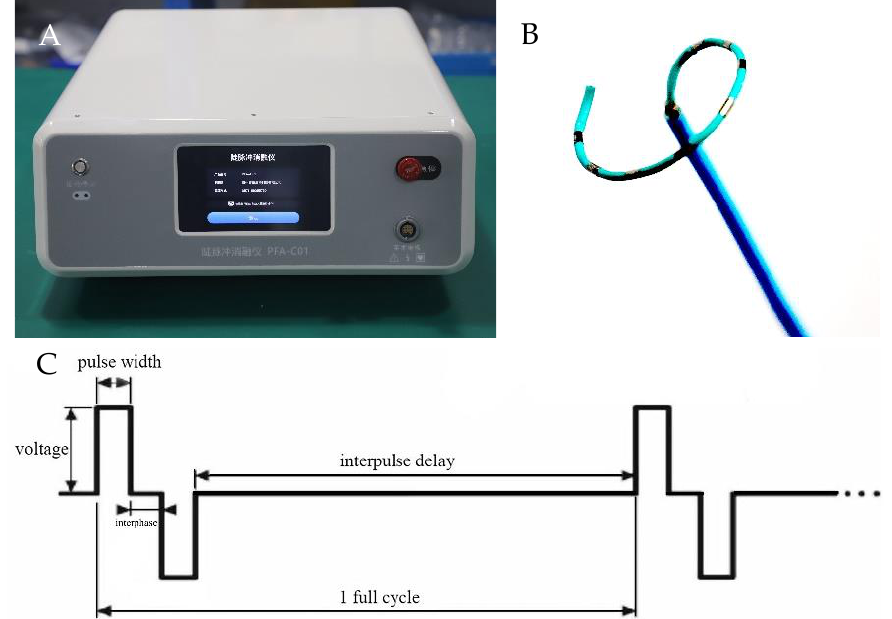
Figure 1. PFA system. ( A ) The biphasic pulse generator was made by Hangzhou Ruidi Biotechnology and weighs 10 kg. ( B ) The mapping/ablation catheter was a 6-French multielectrode flexible circular catheter used for alternating current, bipolar PFA deliveries; the circular catheter includes three models (15, 20, and 25 mm). ( C ) A complete pulse includes positive and negative pulses with the same pulse amplitude and pulse width. The interval between positive and negative pulses is called the interphase. The pulse can be released at a fixed frequency or at each ventricular refractory period.